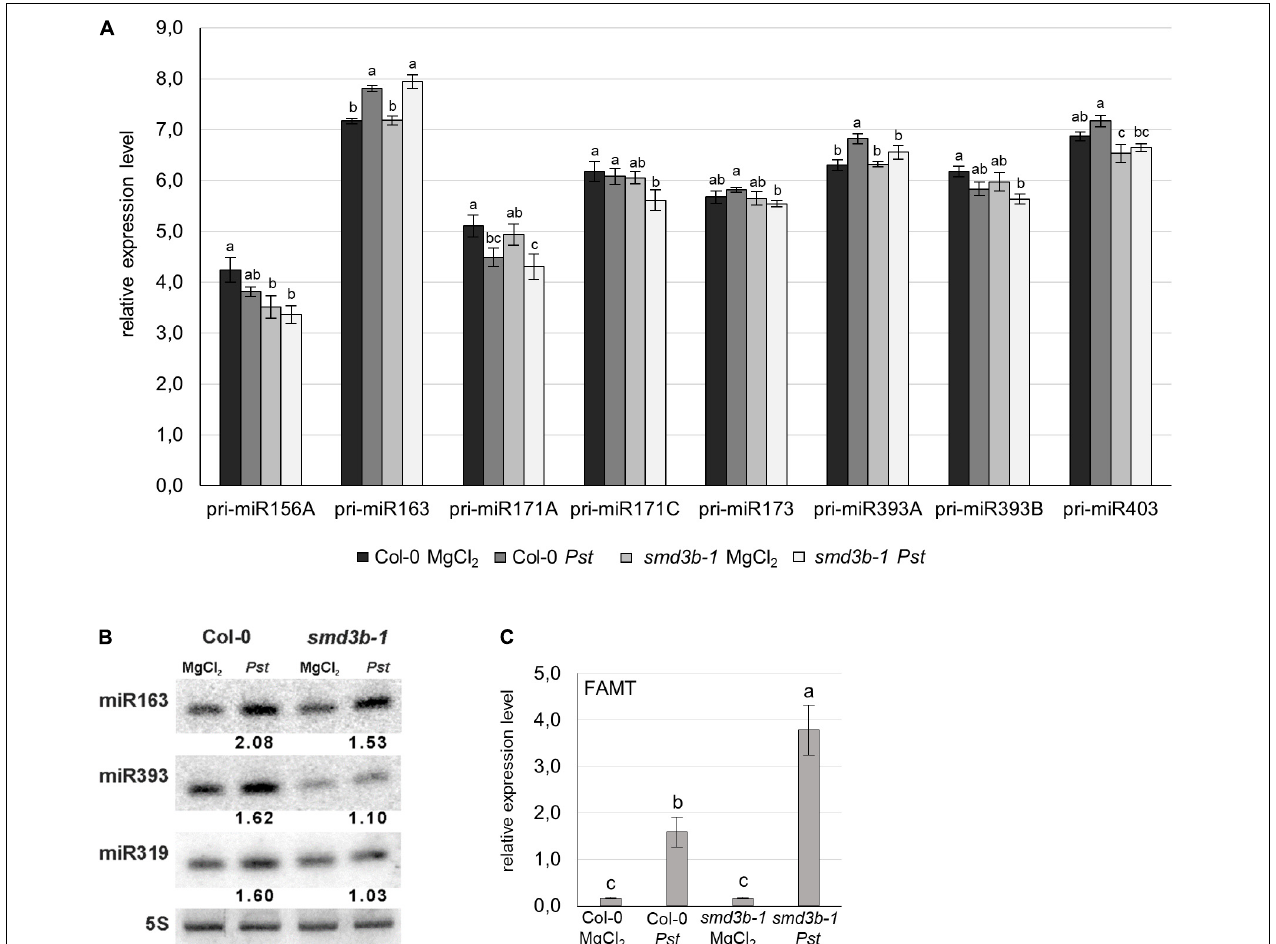
FIGURE 6 | Both smd3b-1 mutation and Pst infection modify the level of pri-miRNA and mature miRNA. (A) RT-qPCR analysis of chosen pri-miRNAs during Pst infection. Samples were collected from 6-week-old control (MgCl 2 ) and infected (48 hpi, Pst ) Col-0 and smd3b-1 plants. Results represent mean of three independent biological replicates with error bars showing SD ; letters represent significant difference ( P < 0.05) for Tukey’s HSD test. GAPDH mRNA was used as a reference. (B) Northern blot analysis of miRNAs involved in pathogen response. Numbers represent the levels of miRNA in Pst -treated Col-0 and the smd3b-1 mutant relative to control (MgCl 2 ), normalized to 5S rRNA loading control. Experiments were repeated at least three times; representative blots are shown. (C) RT-qPCR analysis of miR163 target, FAMT mRNA. Mean values ± SEM were obtained from three independent experiments; letters represent significant difference ( P < 0.05) for Tukey’s HSD test. UBC9 mRNA was used as a